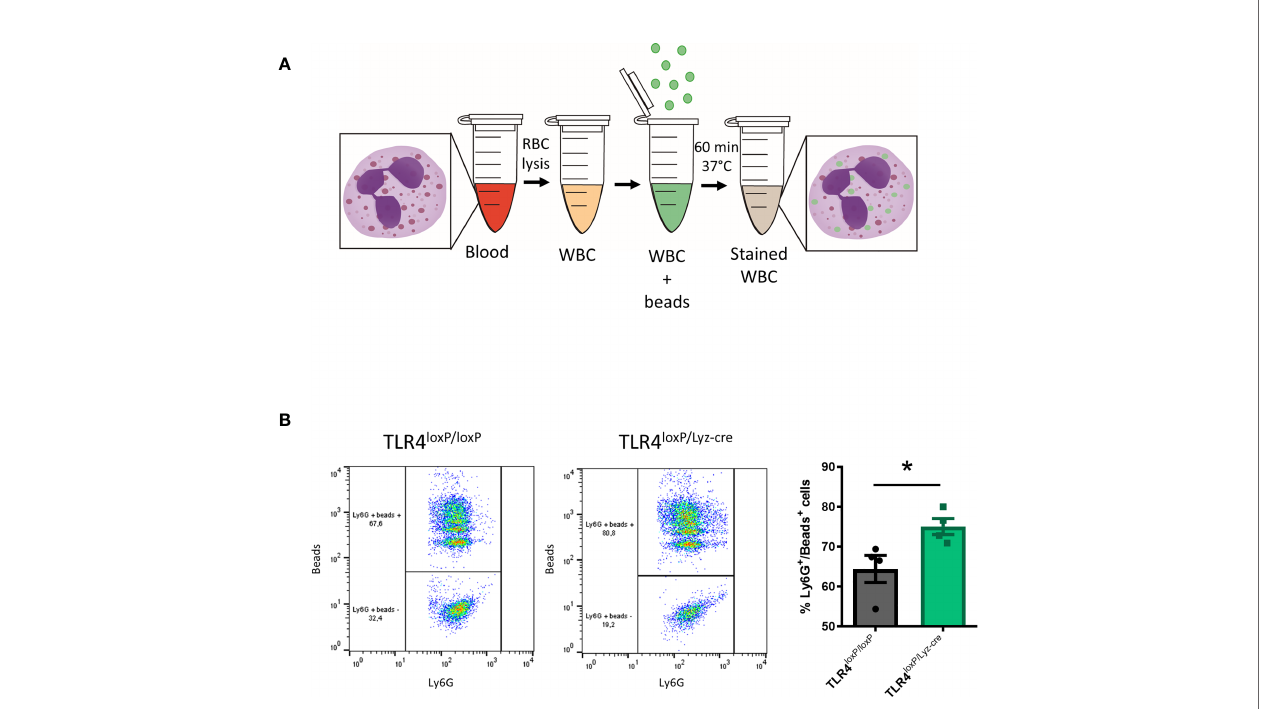
FIGURE 3 | Neutrophil phagocytosis. (A) Experimental design of phagocytic activity of myeloid cells assay. Blood is collected, RBC are lysed, and WBC incubated for 60 min at 37°C with the fl uorescent beads. After incubation cells are washed and stained for Ly6G marker. (B) Flow cytometry analysis of the percentage of neutrophils that had engulfed beads in TLR4 loxP/loxP mice and TLR4 loxP/Lyz-cre mice (*P < 0.05 vs TLR4 loxP/loxP ; n=4-5). Data are mean ±